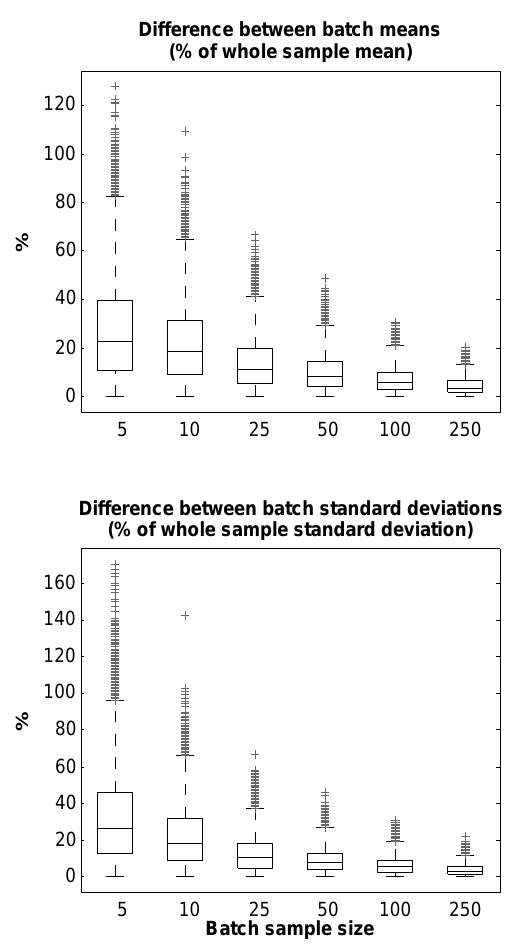
Figure 4. Box plots that show the variation between two batches of simulations reducing as the number of simulations in each batch in- creases. The top plot ( a) shows the difference between the means of the two batches, expressed as a percentage of the mean loss across all 500 simulations. The bottom plot ( b ) shows the difference be- tween the standard deviations of the two batches, expressed as a percentage of the standard deviations across all 500